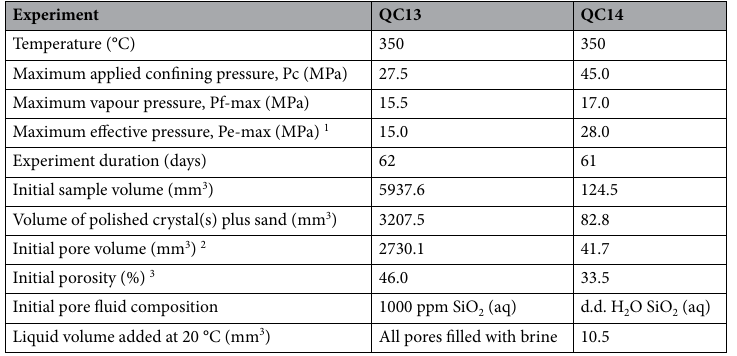
Table 2. Experimental conditions. 1 Calculated from vapour pressure data 21 , assuming liquid plus vapour present in the capsule. Pressure of included air is assumed negligible. 2 Inner volume of the capsule minus the volume of quartz. 3 A lower porosity was achieved for QC14 by gently agitating the gold capsules during and for 5 min after filling with